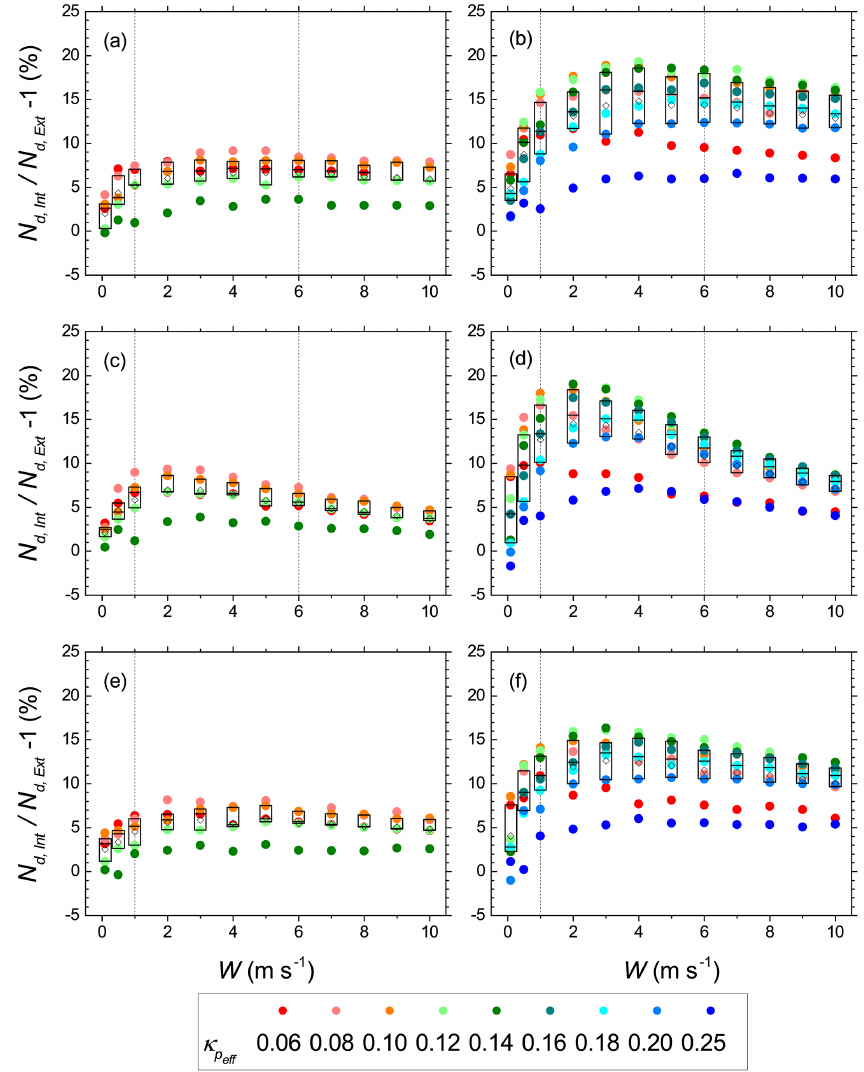
Figure 5. Overestimation of N d when the aerosol is assumed internally mixed, calculated as a function of the hygroscopicity (color scale) and the updraft velocity, for the external mixing Ext 1 (left) and Ext 2 (right). Plots on panels (a, b) , (c, d) and (e, f) correspond to MP 5 , 1 , MP 1 , 5 and HP 5 , 5 case studies, respectively. Box plots on top of data represent the spread for different hygroscopicity parameters. The box boundaries delimitate the interquartile range and mean values are indicated by diamond symbols. Dashed lines represent the approximate boundaries between CCN activation